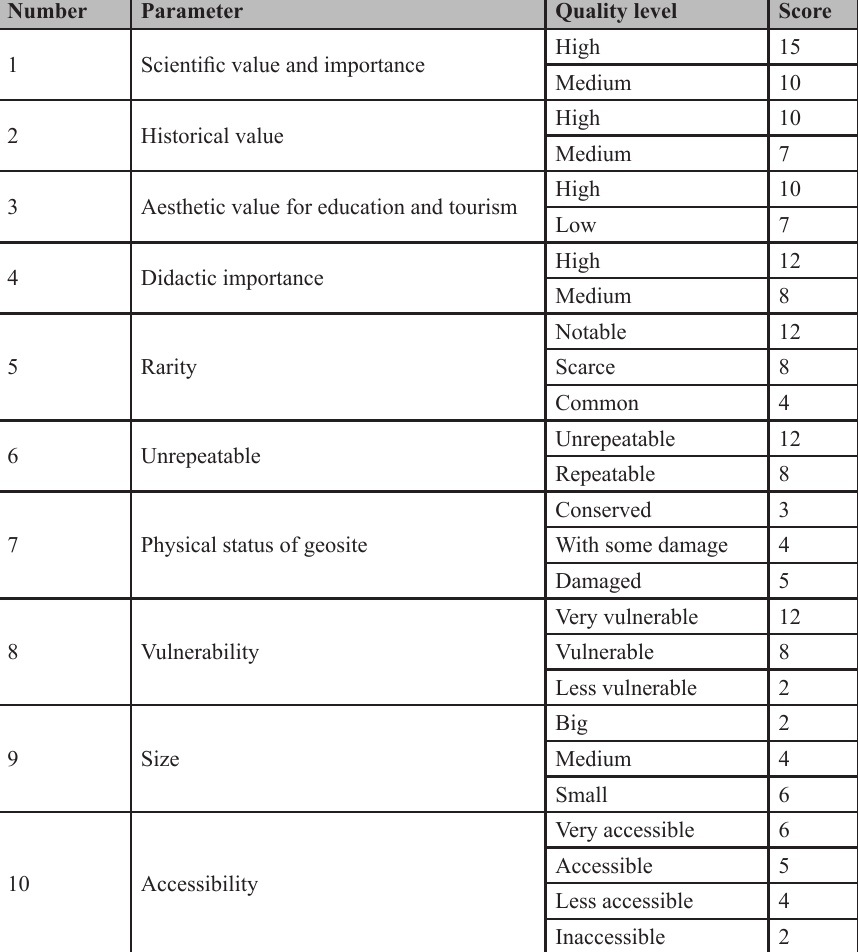
Table 1. Parameters, quality level and proposed score in the geosite scoring methodology proposed by Gutiérrez Domech et al .